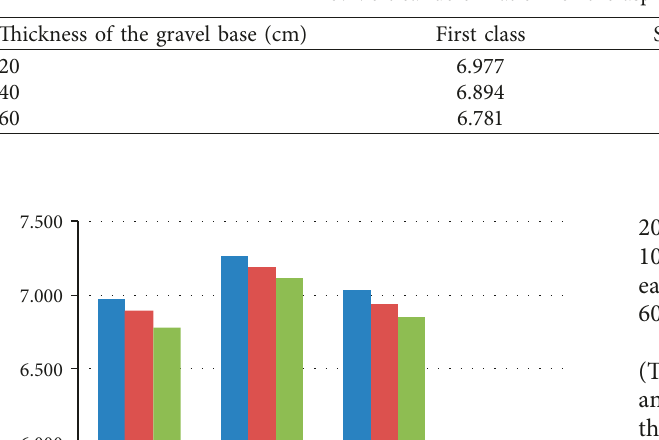
Table 5: Vertical deformation for the asphalt pavement thickness of 20cm.